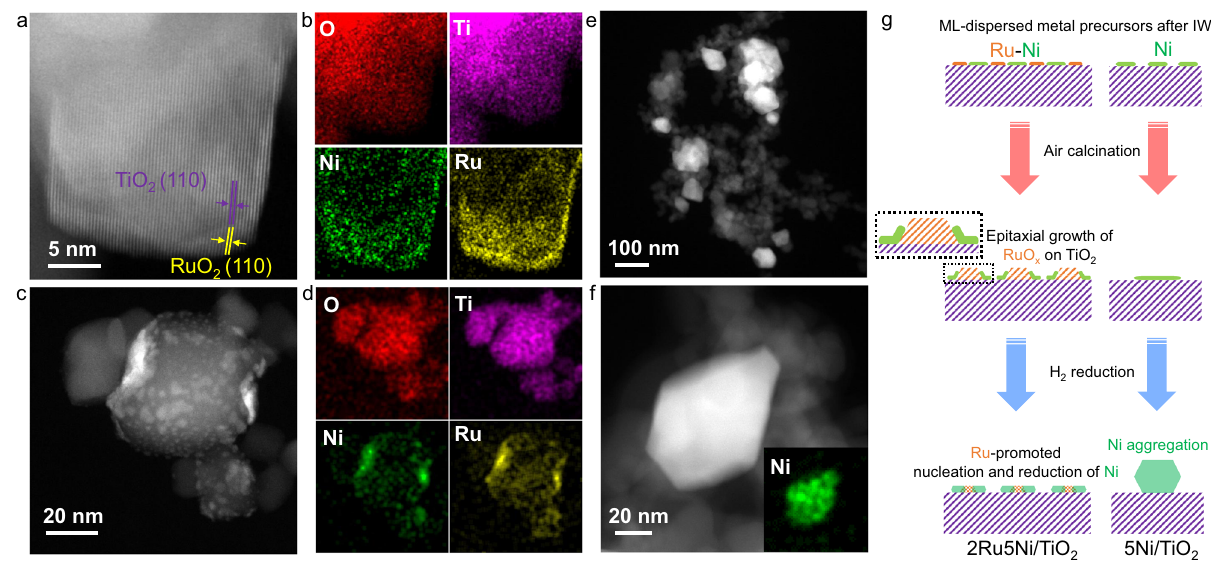
Fig. 2 | Synthesis and microscopy characterization of catalysts. HAADF-STEM and corresponding EDS-mapping images of O, Ti, Ni, and Ru elements of 2Ru5Ni/ TiO 2 after air calcination ( a , b ) and H 2 reduction ( c , d ), respectively. e , f HAADF- STEM images of reduced 5Ni/TiO 2 , the inset image in ( f ) corresponds to the EDS-